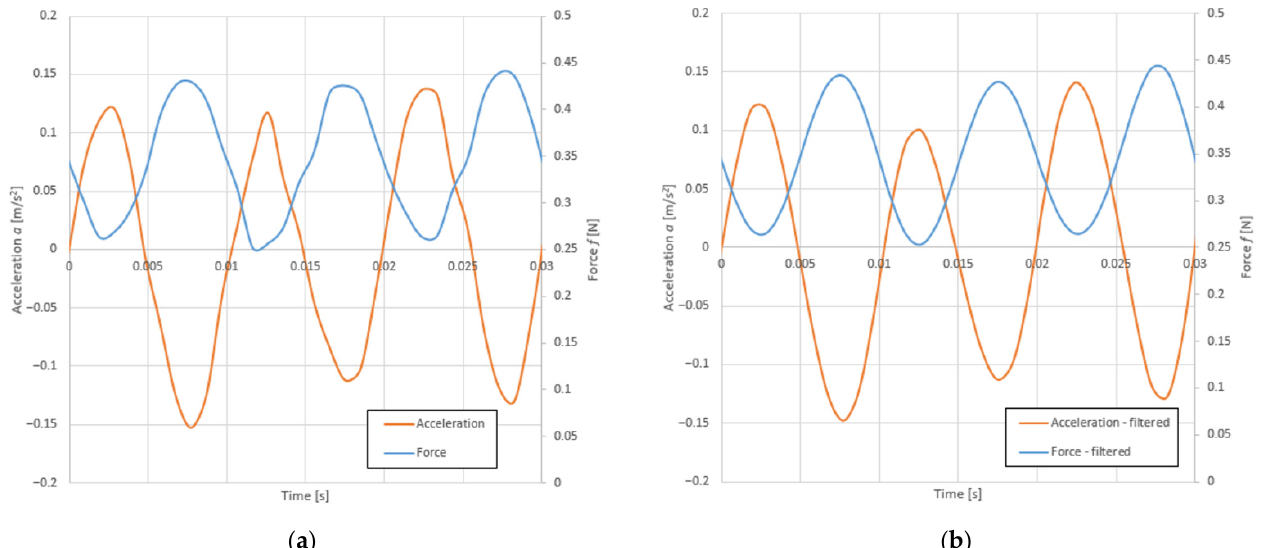
Figure 5. Force applied to tested system and its acceleration response at 100 Hz: ( a ) pure measured signal; ( b ) filtered signal for analysis (own elaboration).